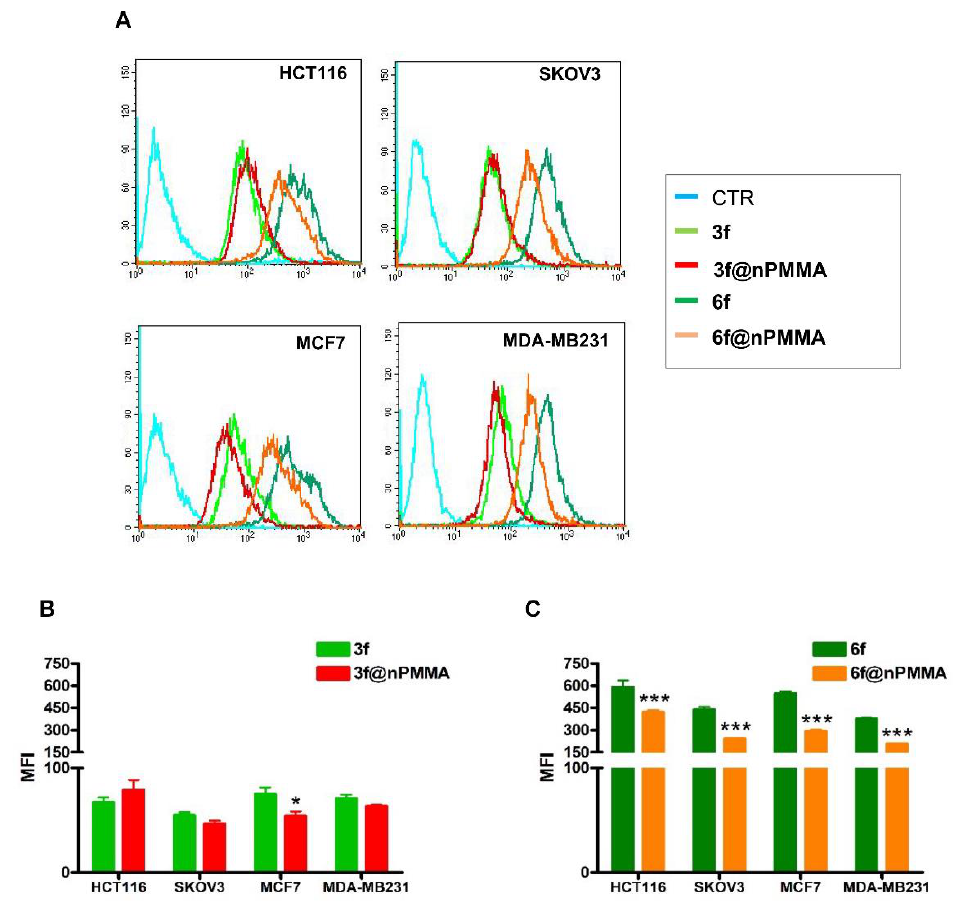
Figure 4. Uptake of 3f (light green histograms or bars), 3f@nPMMA (red histograms or bars), 6f (dark green histograms or bars) and 6f@nPMMA (orange histograms or bars) in monolayer cultured cell lines. The figure shows a representative flow cytometric analysis out of 3 independent experiments with similar results ( A ). The light blue histogram represents controls. Fluorescence intensity was quantitated based on the Median Fluorescence Intensity (MFI) and results obtained in 3 independent experiments are reported in the graphs ( B ) ( 3 ) and ( C ) ( 6 ) (mean ± SE; * p < 0.05 and *** p < 0.001 vs. free molecules).